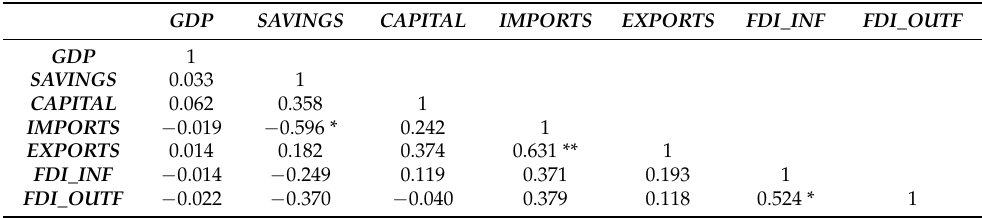
Table 2. Correlation